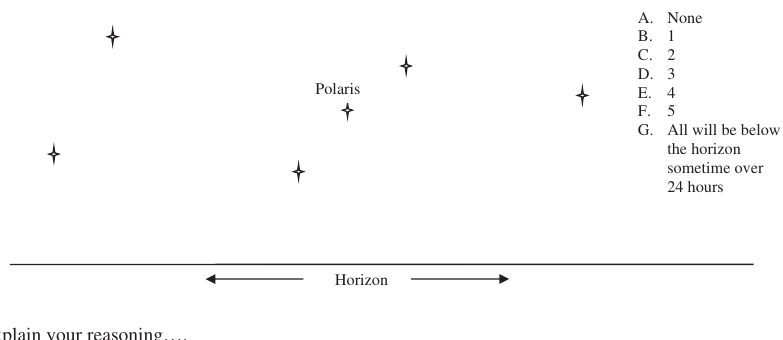
FIG. 9. Assessment used to measure students ’ ability to predict the number of stars that go below the horizon when given the position of Polaris. The distributions of students choosing the correct multiple-choice response and attaining the minimum rubric score can be found in Fig.